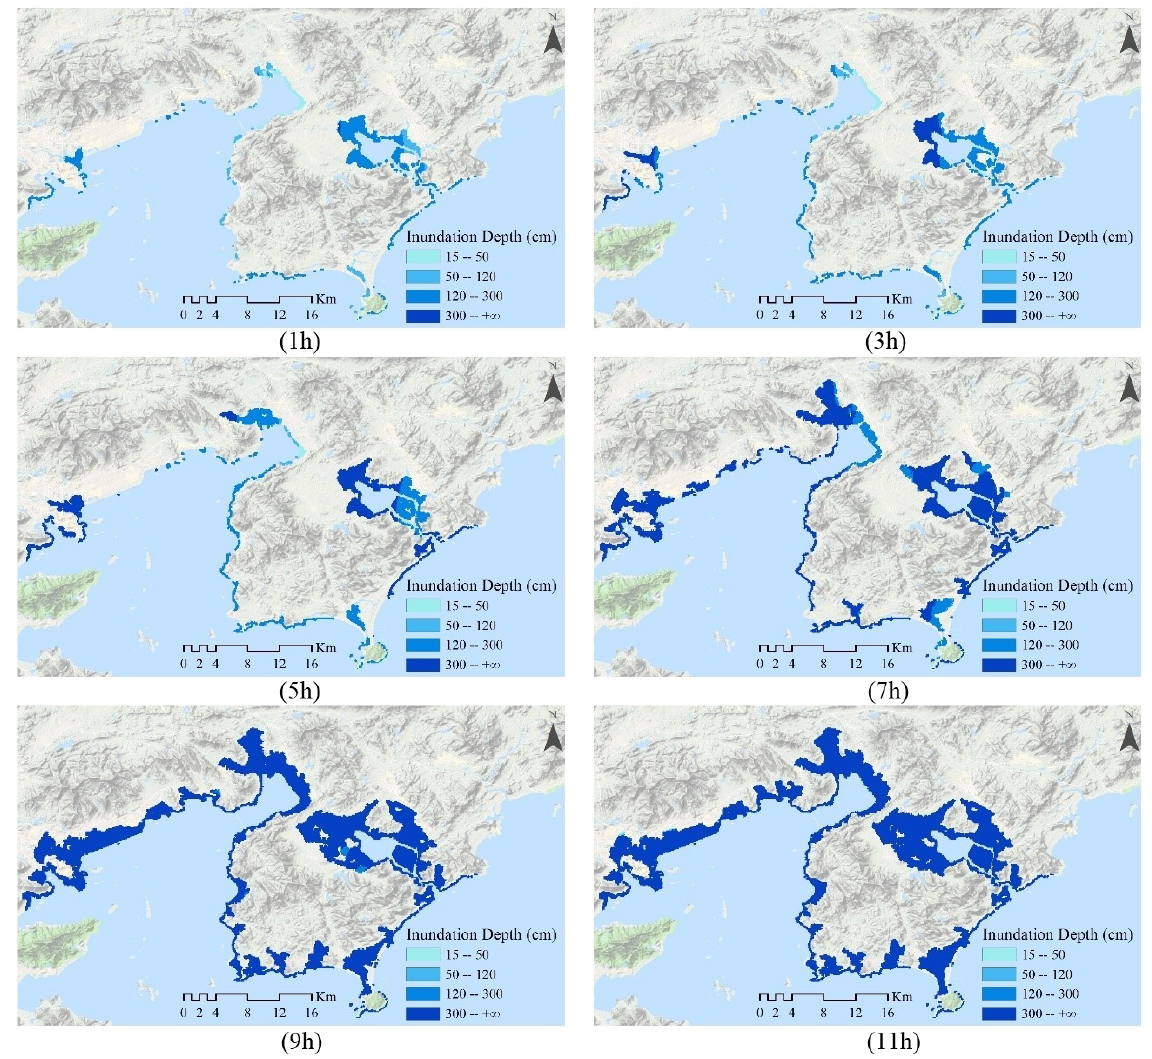
Figure 13. The maps display the simulated inundation extents of storm surge over the study area during 12-hour simulation for the 880hPa (1000-year return period) scenario. These maps were made using the ArcGIS 10.5 software based on the terrain base map layer, which was obtained from © Google Maps (map data © 2019